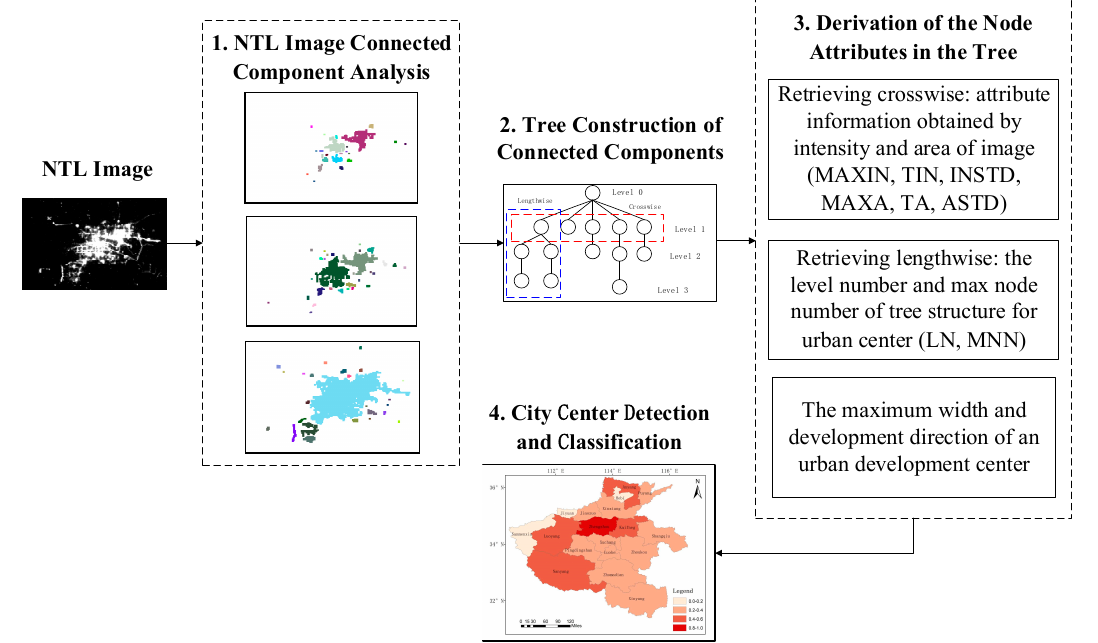
Figure 3. The technical flow chart of the paper.